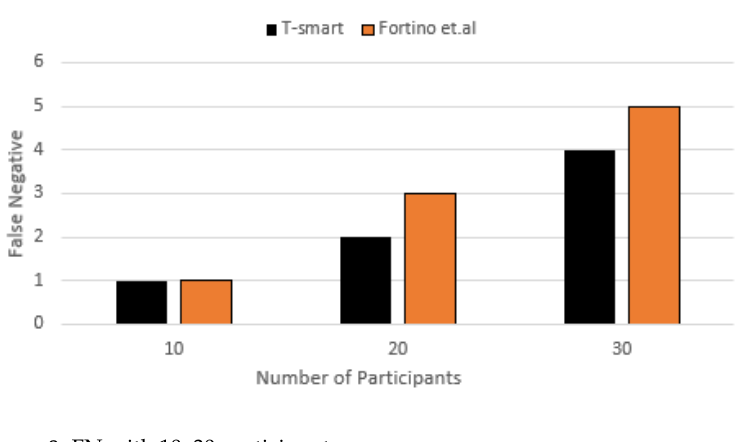
Figure 8. FN with 10–30